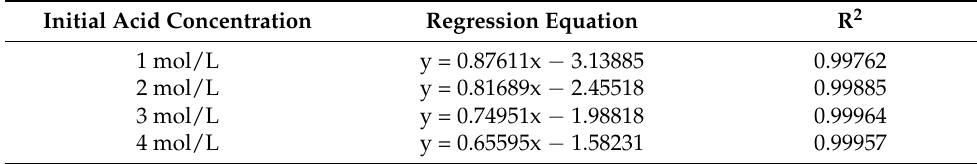
Table 3. Fitting results between ln[ − ln(1 − η )] and lnt under different acid concentrations.